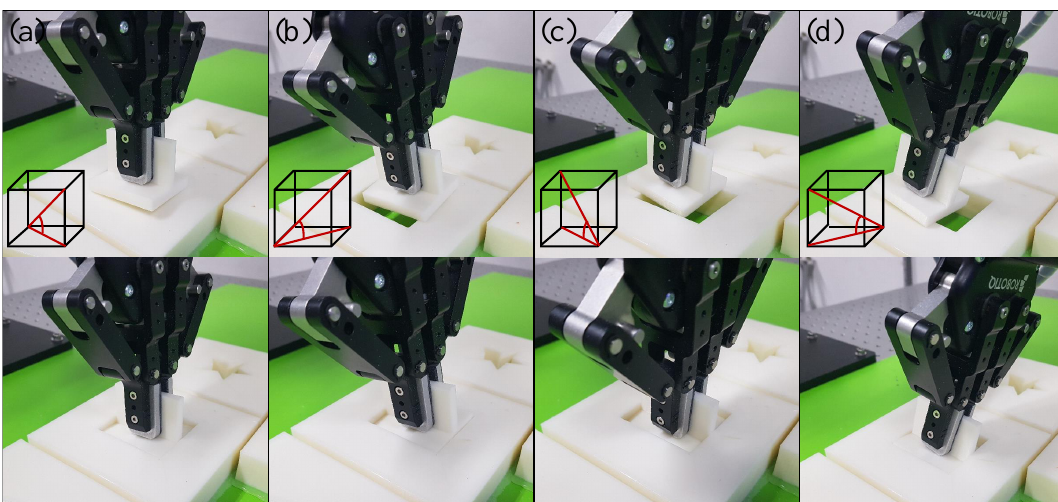
Figure 6. Four peg directions of a human demonstration of the “hole search” and “peg insertion” motor skills of the peg-in-hole task: ( a ) 30 ◦ ; ( b ) 120 ◦ ; ( c ) 210 ◦ ; and ( d ) 300 ◦ . The upper and lower rows illustrate the motions of “hole search” and “peg insertion”, respectively. In the upper low, the black boxes (holes) and red lines (pegs) indicate relative postures.